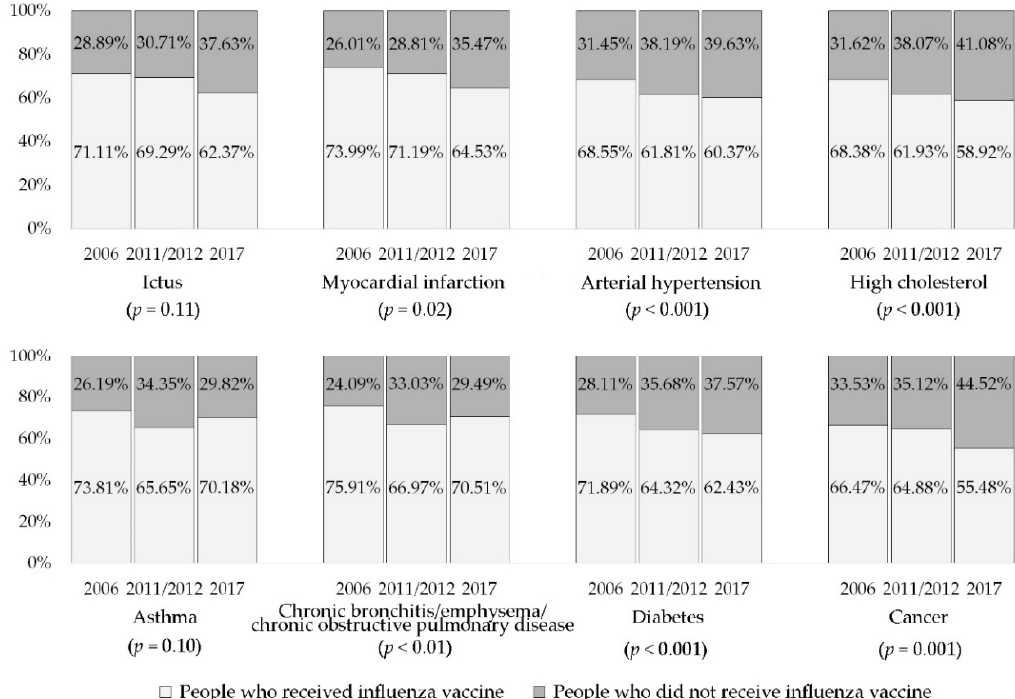
Figure 1. Patterns of influenza vaccination coverage according to chronic diseases in people aged ≥ 65 years in Spain. Spanish National Health Surveys 2006–2017.